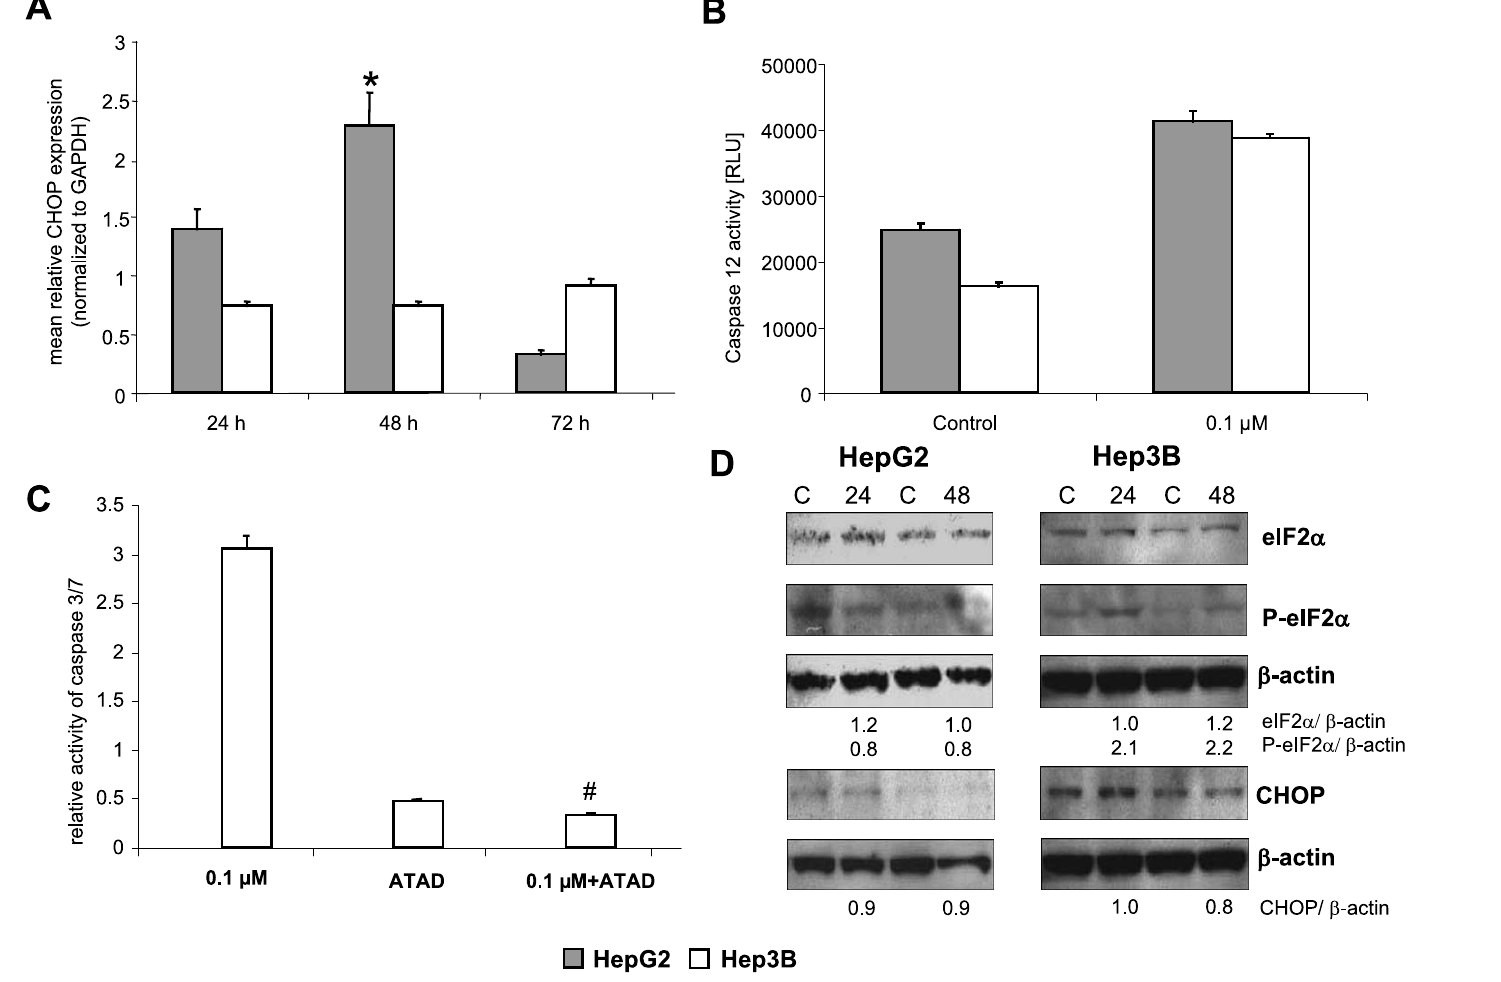
Fig. 4. Analysis of alternative apoptosis pathways. Quantitative real-time RT-PCR analysis of the endoplasmic reticulum stress related gene CHOP shows a significant induction of the UPR after 48 h in HepG2 but not in Hep3B (A). Results were normalized to GAPDH expression levels. Activity of the ER-stress associated caspase 12 was increased after panobinostat treatment (B). Downstream activity of caspases 3 / 7 was decreased after inhibition of caspase 12 with ATAD (C). Westernblot analysis of effector proteins of ER stress after 24 and 48 h treatment with 0.1 µM panobinostat (D). * P < 0 . 05 vs. control or # P < 0 . 05 vs. panobinostat